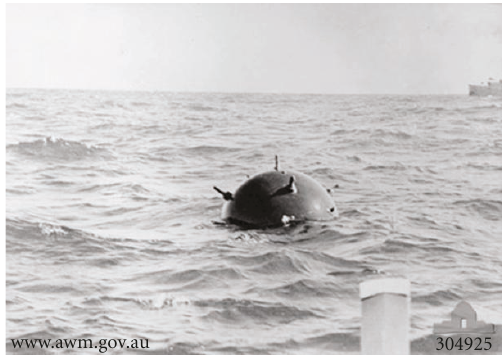
Figure 1: A WWII German floating mine. (Australian War Memorial (AWM) catalog number